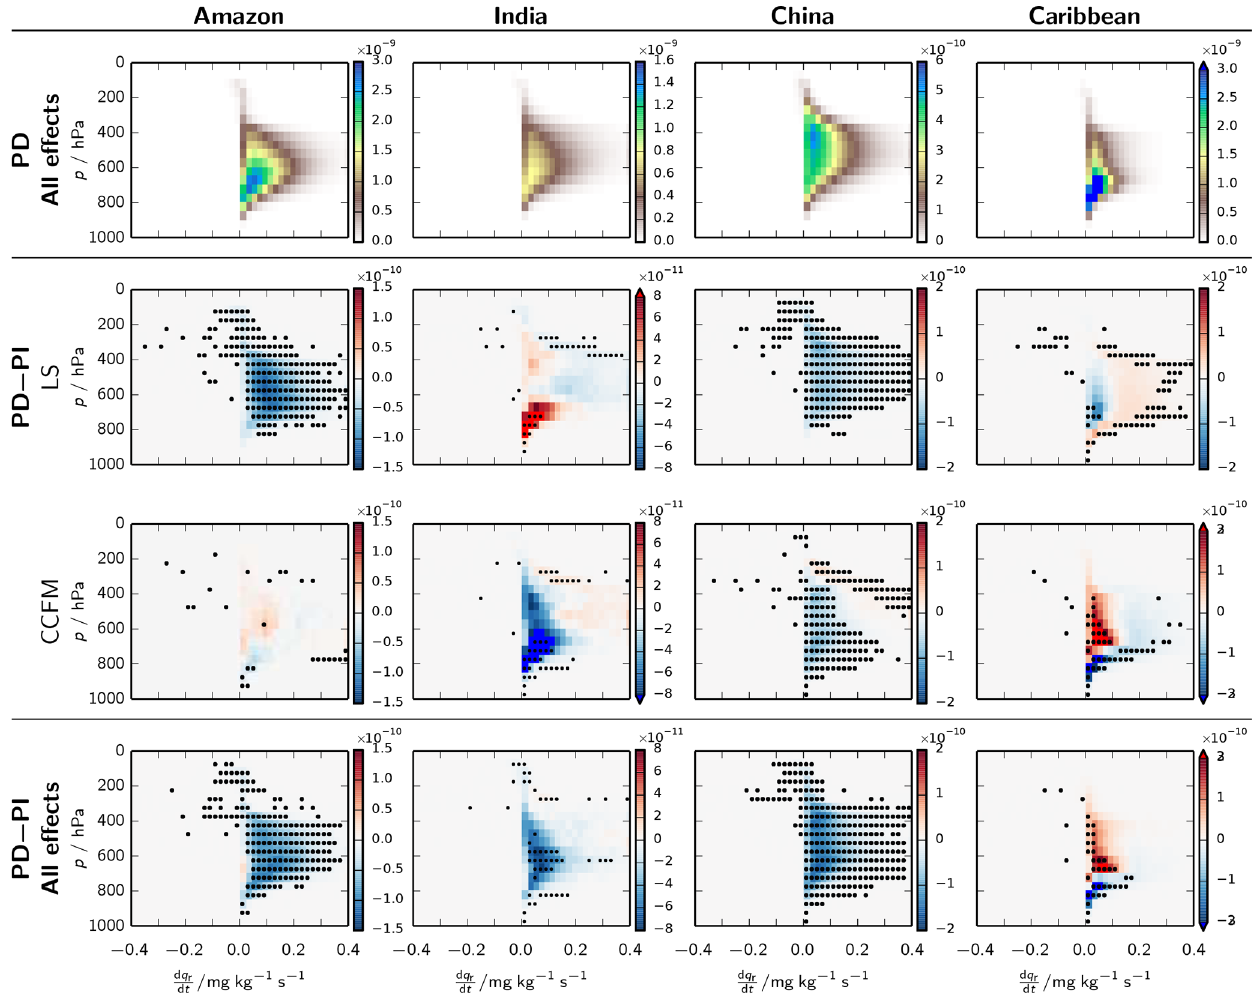
Figure 6. Regional change in the vertical profile of rain production within CCFM clouds, weighted by mass. The top row shows the PD distributions, while the bottom row shows the PD–PI difference (both with all effects included); the middle rows show the contributions from large-scale and CCFM (convective) mechanisms. Note that the colour scales are identical between mechanisms to allow comparison of their magnitude, but not between the different regions. A further breakdown into individual process effects, along with additional regions, is included in the Supplement. (PD: present-day aerosol; PI: pre-industrial aerosol; black dots indicate histogram bins where the PD–PI difference is statistically significant at the 95%